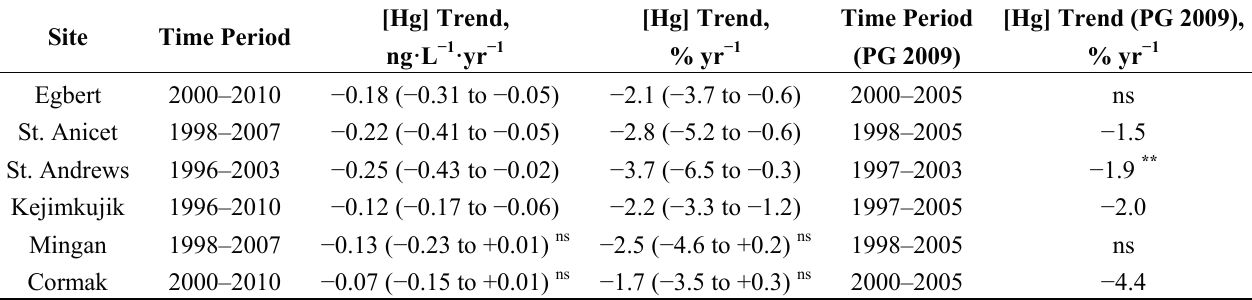
Table 5. Trends (with 95% confidence limits) in total Hg in precipitation at sites with >5 years of measurements, as well as results from Prestbo and Gay (PG) 2009. Concentrations are volume weighted means (ns = not